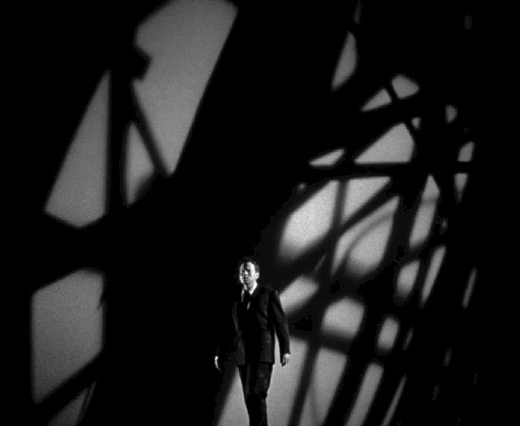
Figure 5 Stourhead, Wiltshire, UK (construction: 1741-1780) (Photo by the